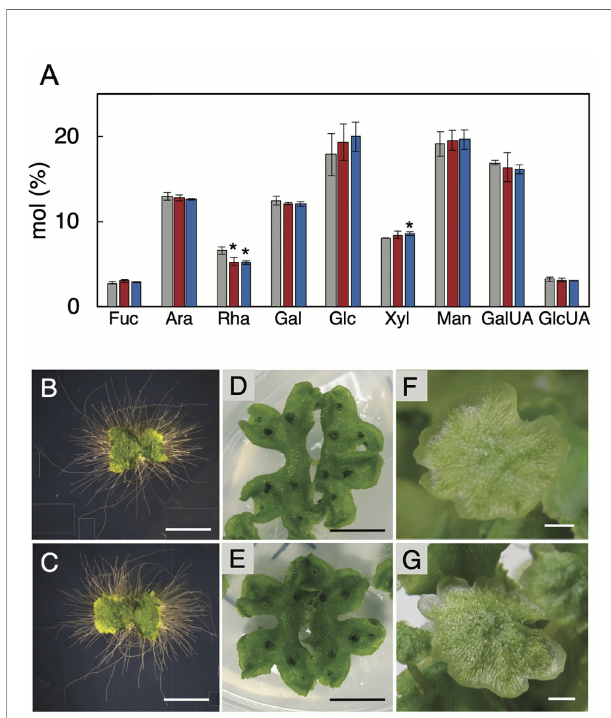
FIGURE 5 | Chemotype and phenotype of the Mp RRT1 genome-edited lines. (A) Monosaccharide compositions of thalli in the Mp RRT1 genome- edited lines. Tri fl uoroacetic acid-hydrolysate non-cellulosic fractions from 21- day-old gemmalings of Tak-1 (gray), Mp rrt1-1 (red), and Mp rrt1-2 (blue) strains were subjected to ion-chromatography. The monosaccharide contents are shown as the percentages of the total amounts of monosaccharides. Values represent means of three biologically independent samples with SD. Asterisks indicate that the value was signi fi cantly different from that of Tak-1 by Student ’ s t-test: *P < 0.05. Ara, arabinose; Rha, rhamnose; Fuc, fucose; Xyl, xylose; Man, mannose; Gal, galactose; Glc, glucose; GalUA, galacturonic acid; GlcUA, glucuronic acid. Nine-day-old gemmalings of Tak-1 (B) and the Mp rrt1-1 mutant (C) . Gemmalings were grown on medium covered with cellophane to clearly observe rhizoids. Twenty-one-day-old gemmalings of Tak-1 (D) and the Mp rrt1-1 mutant (E) . Antheridiophores of Tak-1 (F) and the Mp rrt1-1 mutant (G) . Bars, 2 mm (B, C, F, G) and 1 cm (D, E)